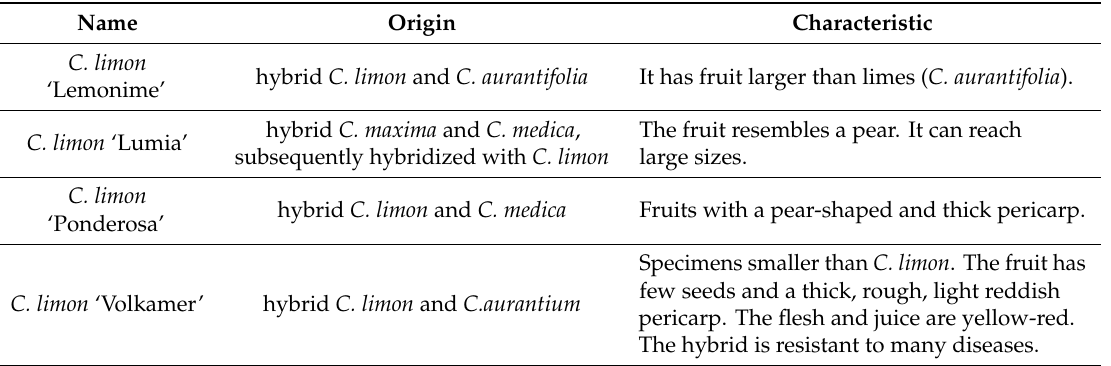
Table 2. Hybrids of C. limon